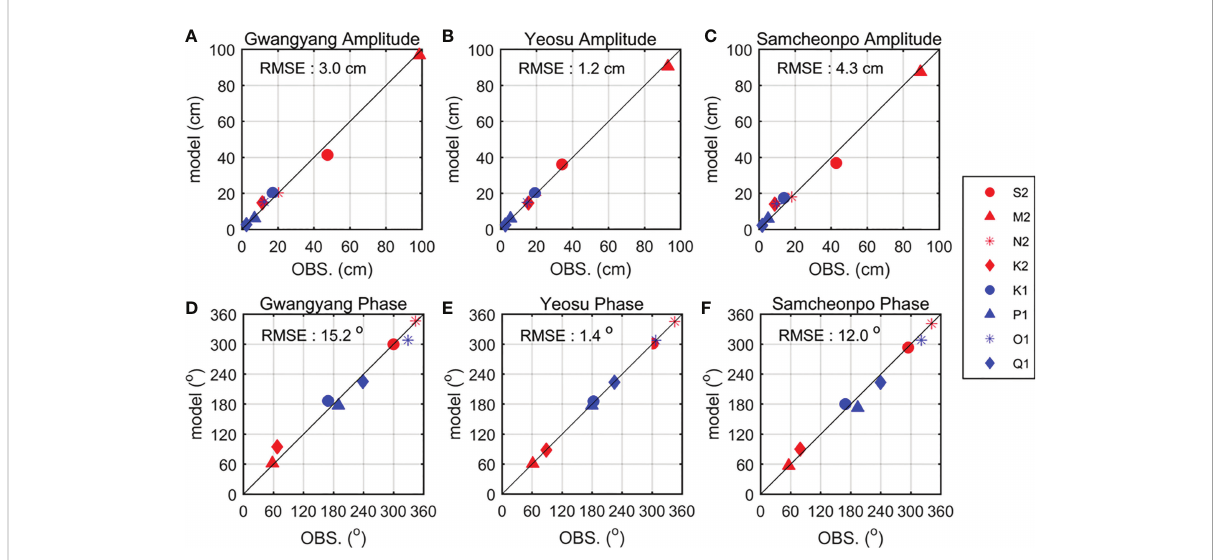
FIGURE 2 Comparison of the tidal amplitude and phases of the model and observations at: (A) and (D) Gwangyang, (B) and (E) Yeosu, and (C) and (F) Samcheonpo tidal stations (see Figure 1 for the